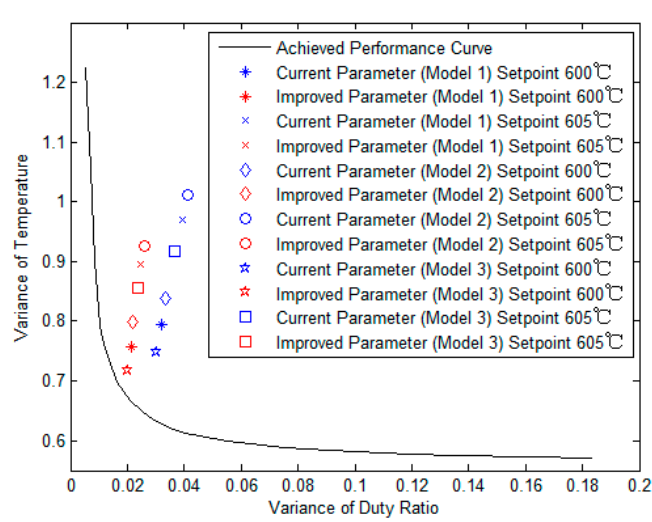
Figure 6. Limit curve based on LQG performance and actual variance of the system.